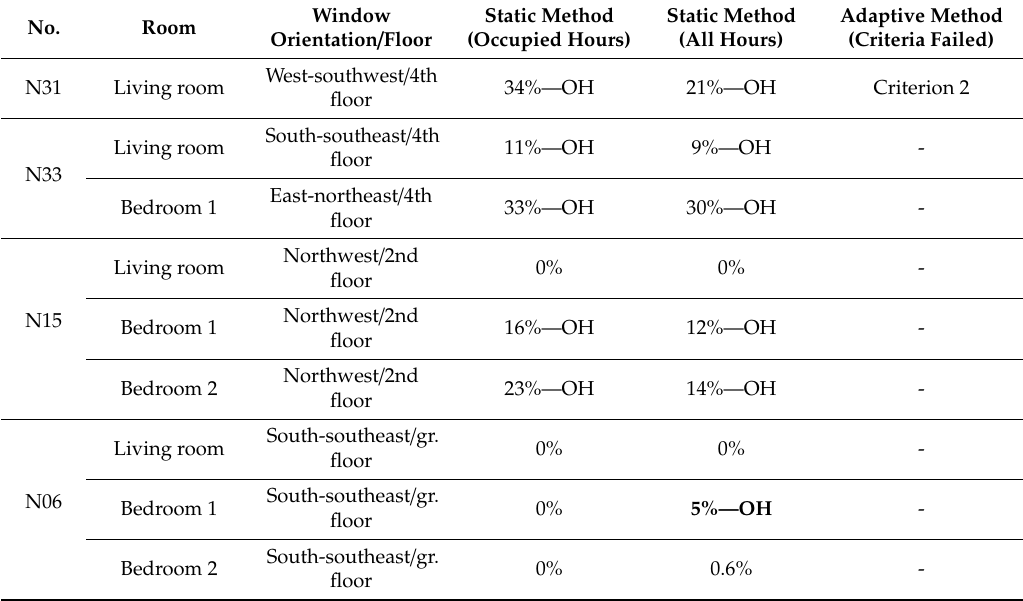
Table 8. Overheating results (OH = overheating).